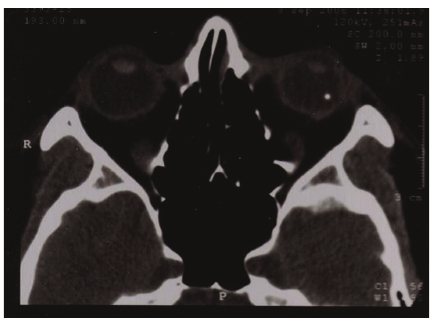
Figure 1: CT-scan depicting an intraocular foreign body in the left eye.